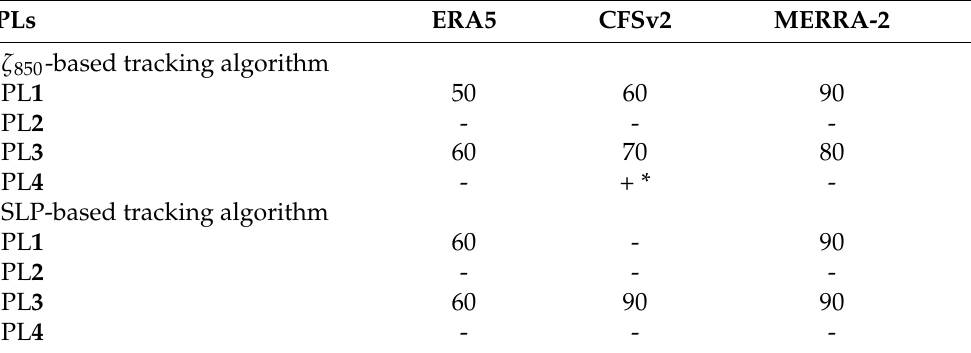
Table 1. PL track errors (km) for ERA5, MERRA-2 and CFSv2 data sets compared to satellite observations. *—the “+” symbol indicates that the PL 4 has been identified, but the track error